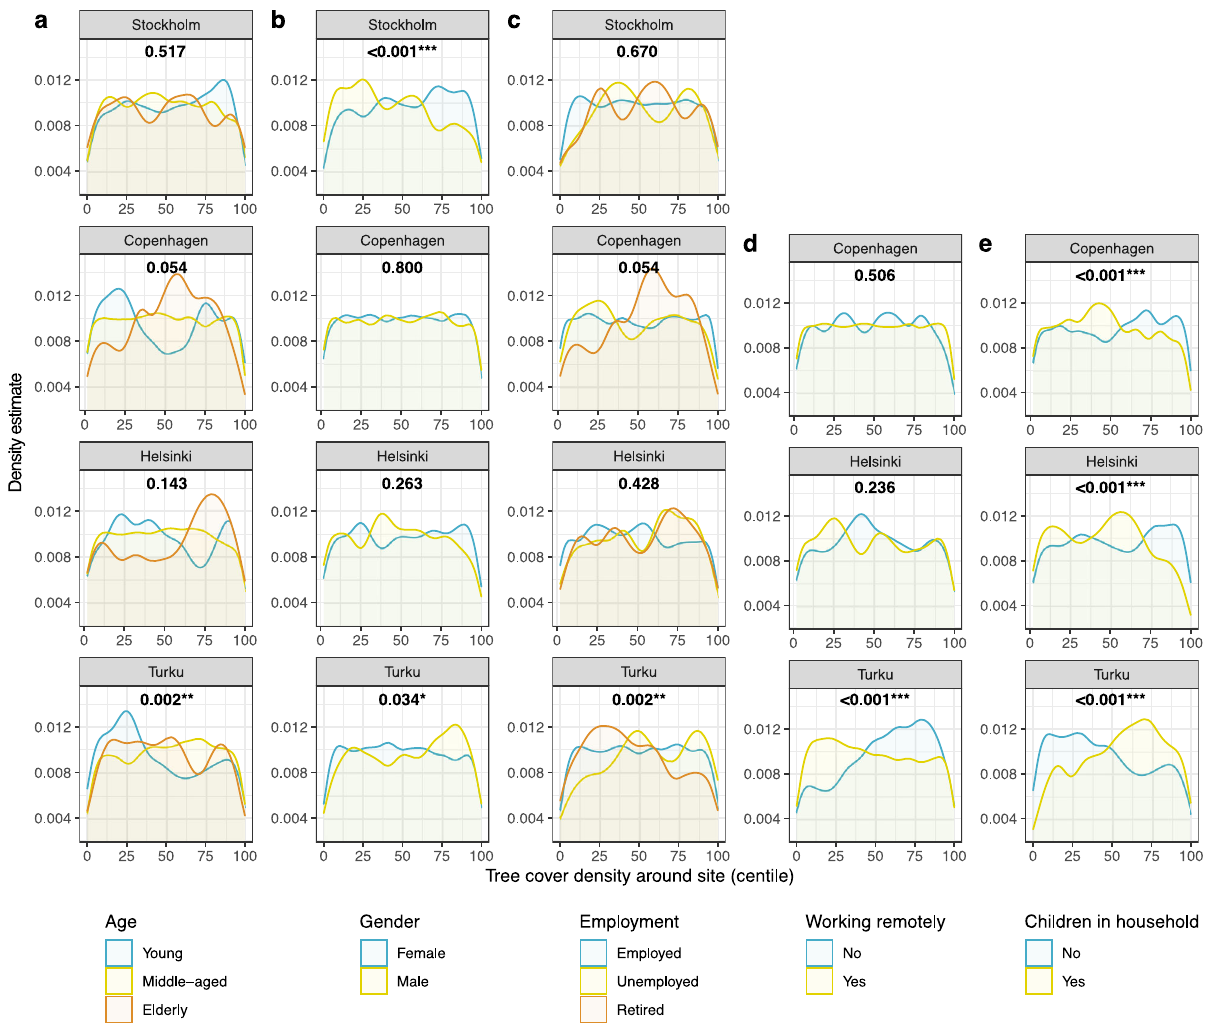
Fig. 3 Tree cover density (TCD) within 300m distance around the visited outdoor recreation sites. TCD in centiles of rank order is given on the x -axis and kernel density estimates are given on the y -axis. Panels show data broken down by city and a age, b gender, c employment, d remote working, and e children in household. The numbers in each plot correspond to the p -value for the Mann – Whitney U -test or Kruskal – Wallis test for differences between groups shown in the plot. Rank order centiles are shown to illustrate group differences as estimated by the tests used. See also Supplementary Tables 3, 5, 7 and 9 on statistical results as